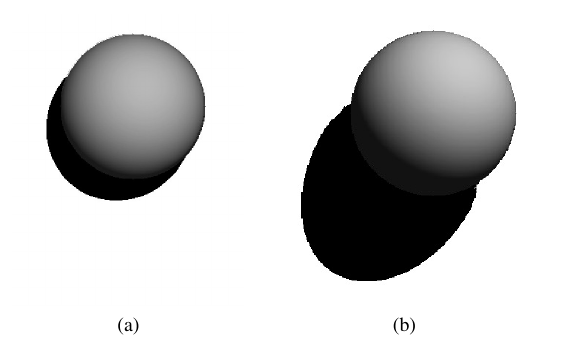
Figure 1: Illustration of the geometrical-optical model of tree crown as seen in two different solar elevation angles: (a) 20 ◦ and (b) 45 ◦